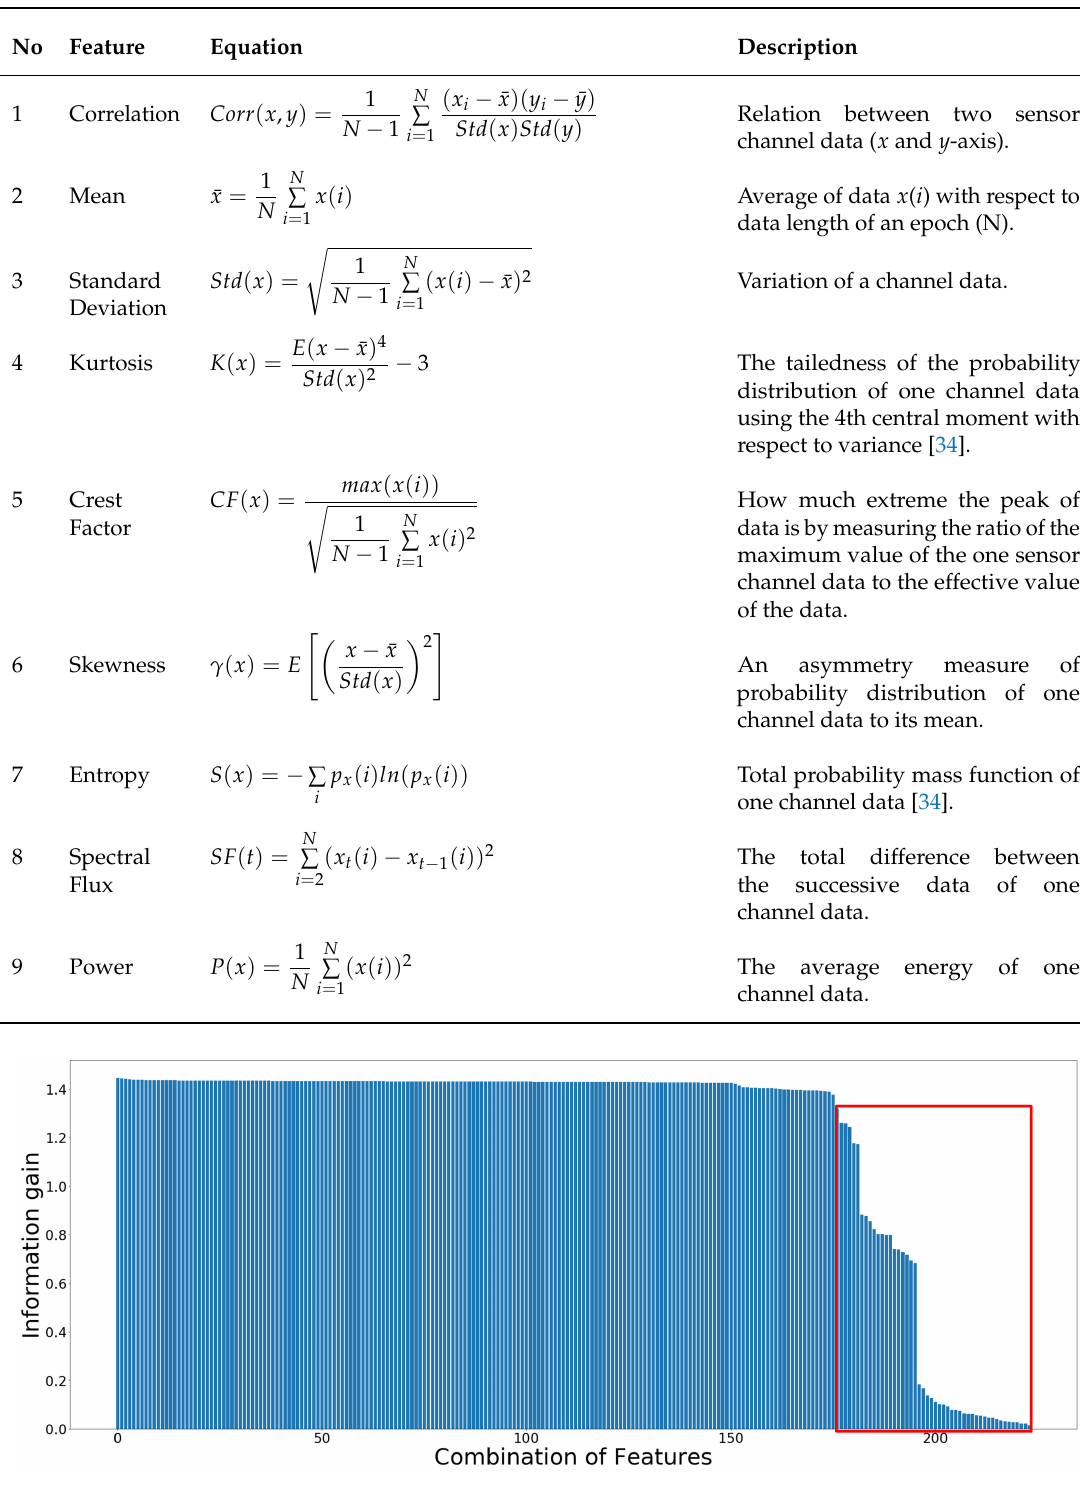
Table 1. The nine features in time–frequency domains.